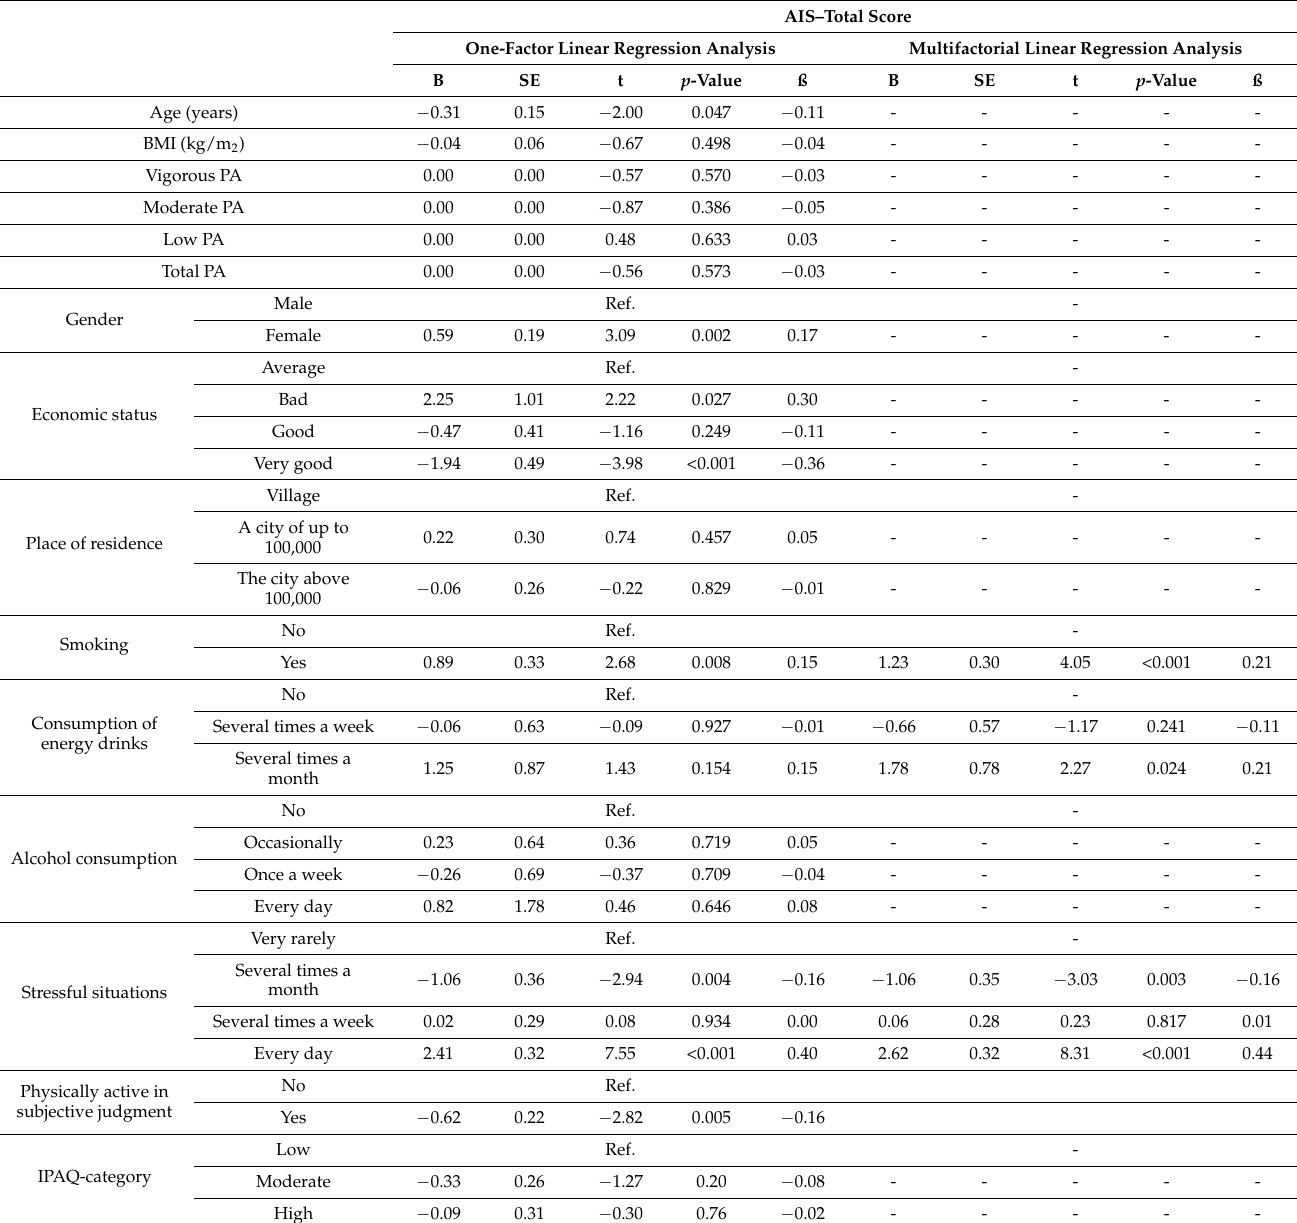
Table 4. Single-factor and multi-factor linear regression analysis assessing the effect of selected variables on insomnia (AIS).